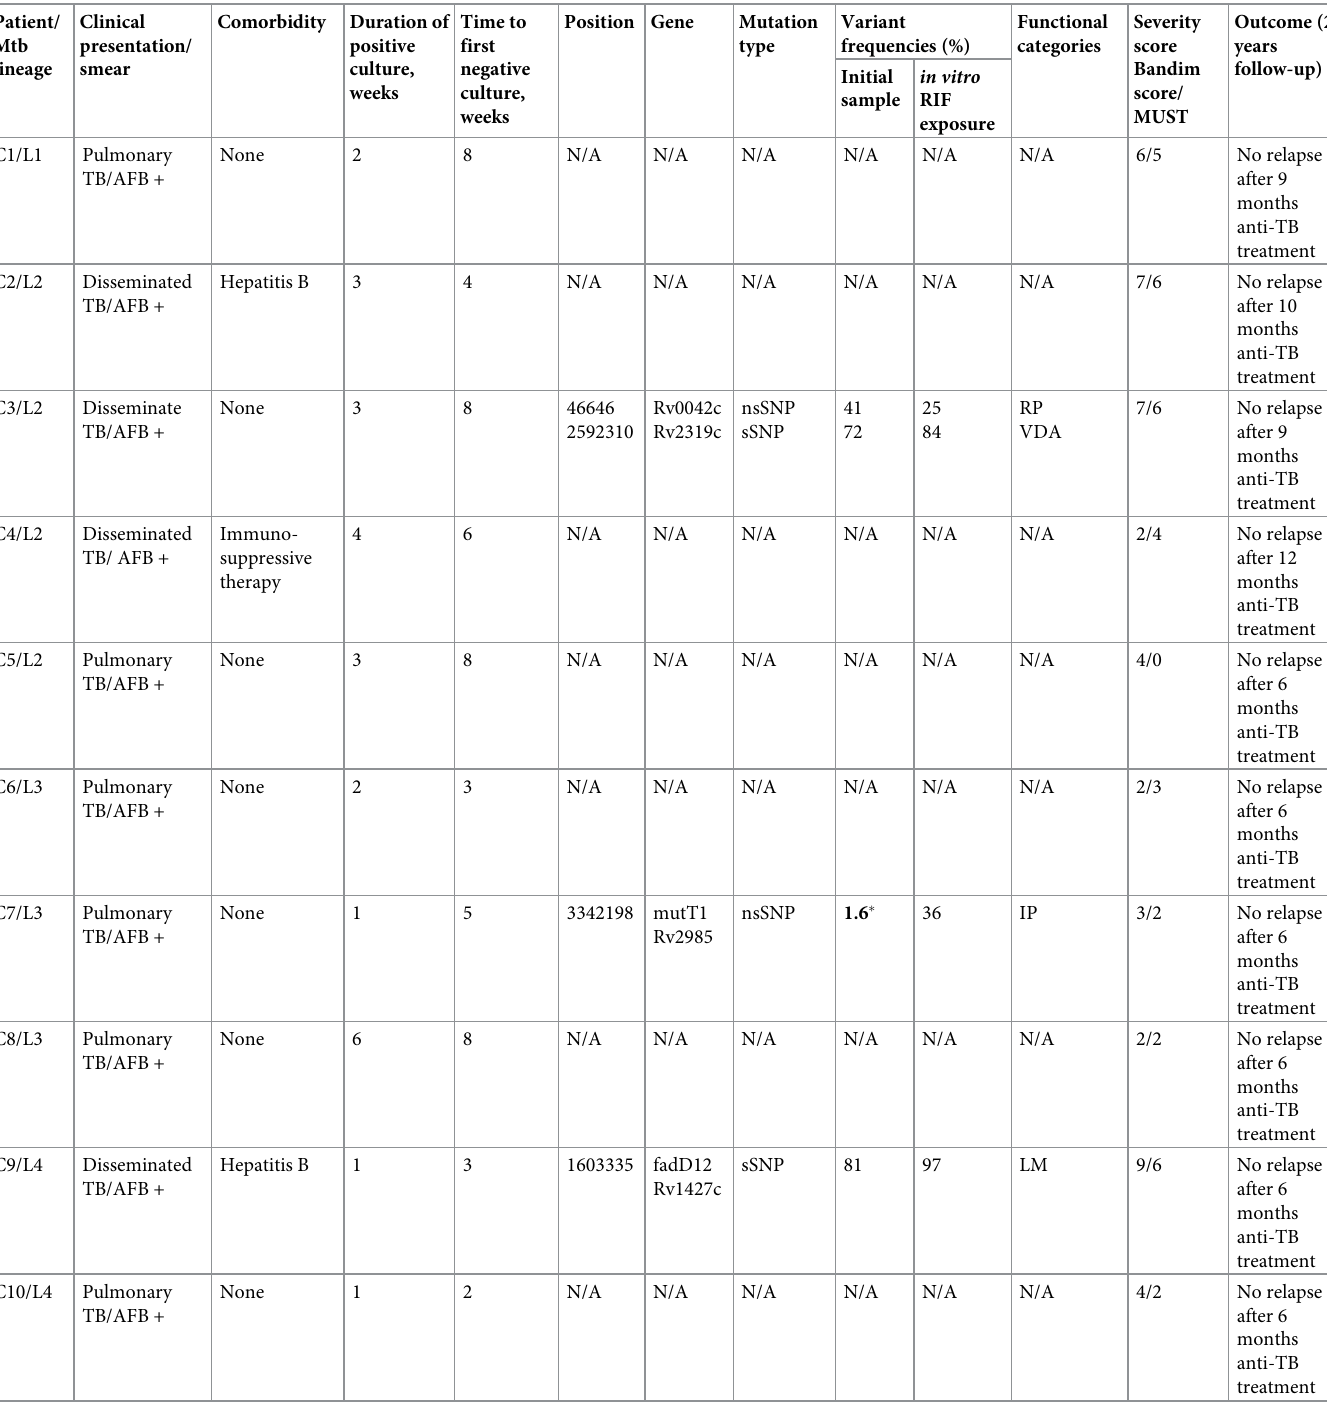
Table 2. Mtb variants from control clinical isolates and emerging after 4 weeks of exposure to 1x MIC RIF in vitro